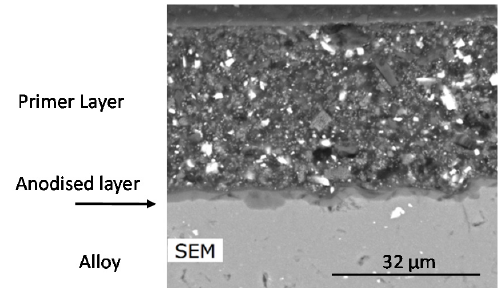
Table 2. Inorganic additive size distribution presented as the percentage of particles at a particular size in microns.